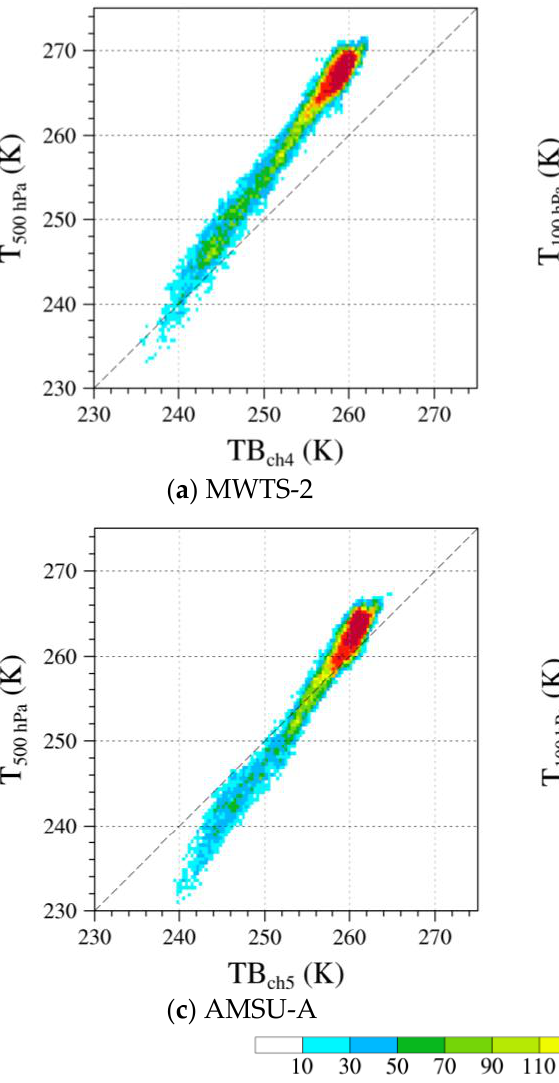
( b ) Figure 6. Scatterplots of latitudinal distributions of FY-3D MWTS-2 brightness temperature observations of ( a ) channel 4 and ( b ) channel 8 for all clear-sky nadir points over the ocean during the time from 10 to 31 July 2019 (gray dots). Also shown are the mean values (black curve) and mean ± one-standard deviation (red dashed curves) and data counts (black dotted curves) calculated at 2° latitudinal intervals. The high correlations between the TBs and the air temperature at channel WFPs al- low temperature retrieval using the multiple linear regression method. According to the Rayleigh-Jeans approximation, the MWTS-2-received upward radiation emission at a specific channel ( i ) is a linear function of temperature ( T ). Specifically, the air tempera-